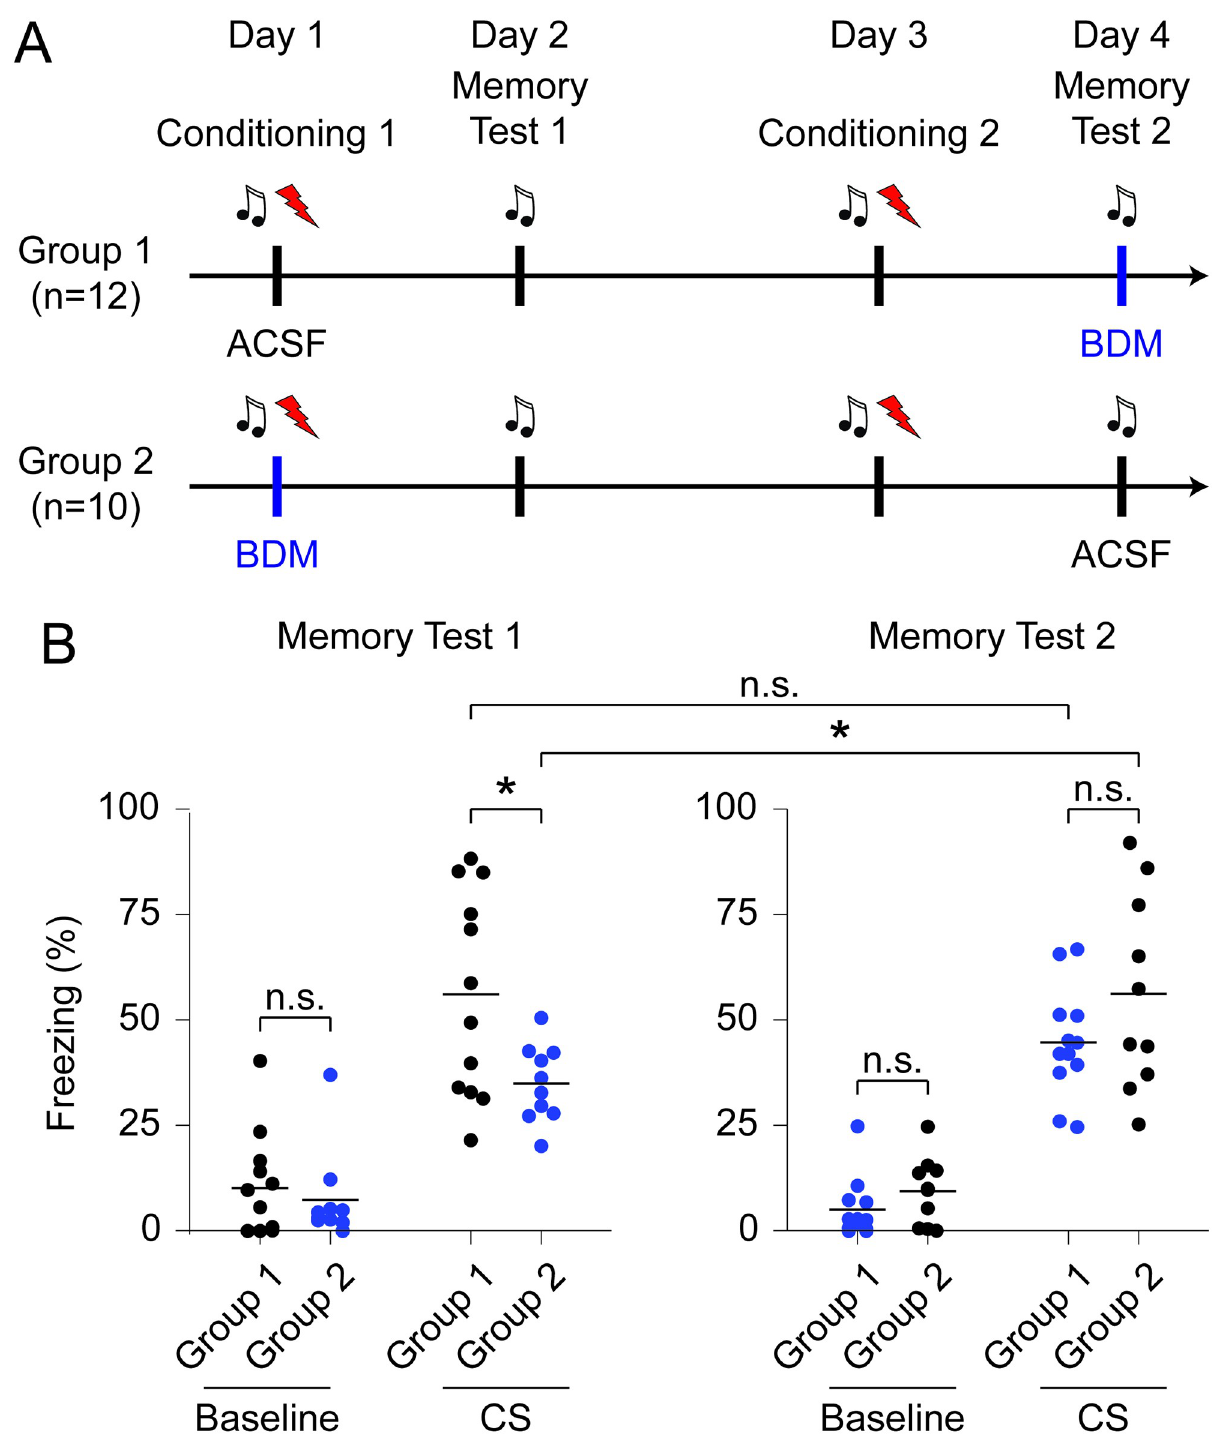
Fig 6. BDM mediated inhibition of chromatin dynamics in auditory cortex impairs memory formation, but not retrieval. ( A ) Schematic of experiment: Group 1 was infused with ACSF during first conditioning session, and with BDM during second memory test. Group 2 was infused with BDM during first conditioning session, and with ACSF during second memory test. Each behavioral session was separated by one day. ( B ) Quantification of freezing behavior of mice during both memory tests. Shown is freezing during first 30 seconds baseline in silence and during replay of the conditioned sound stimulus. Black: ACSF; blue: